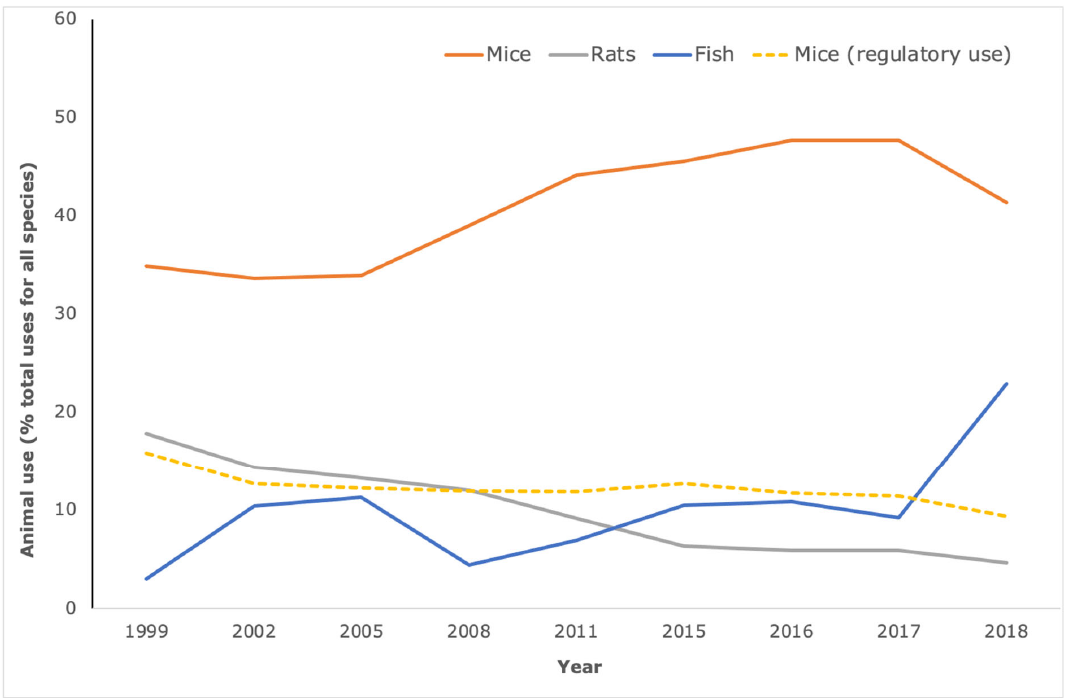
Figure 2. Mice comprise the majority species used in Basic Research and Translational & applied Research. According to the European Commission statistical reports on animal use, the species most commonly used for biomedical research are mice (orange line) rats (grey line) or fish (including zebrafish) blue line. For mice, this equates to over four million uses per year for these purposes, representing around 80% of the annual, total mouse use and around 50% of total animal use. In contrast, mouse use for regulatory use and routine production (yellow dotted line) is on the decline and is less than 10% of total animal use. Note that the increase in fish use for 2018 is attributable to the inclusion of data from Norway for the first time.